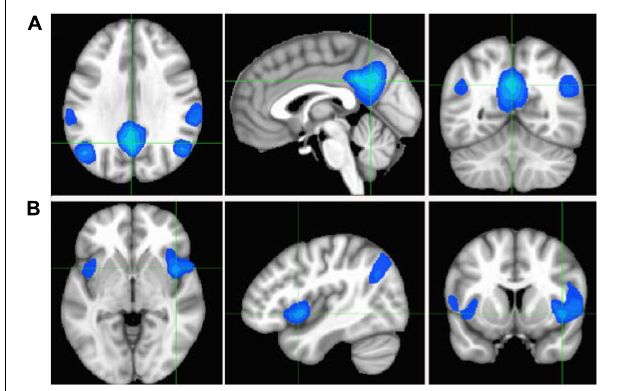
FIGURE 8 | Cross-sectional display of the anti-correlation network associated with the PCC (A) and insula (B) seeds as derived by multiplying the correlation maps shown in Figures 7B,C and applying a negative threshold at CC ≤ ( − 0. 5). The crossing points of green lines depict the center of mass for PCC and insula